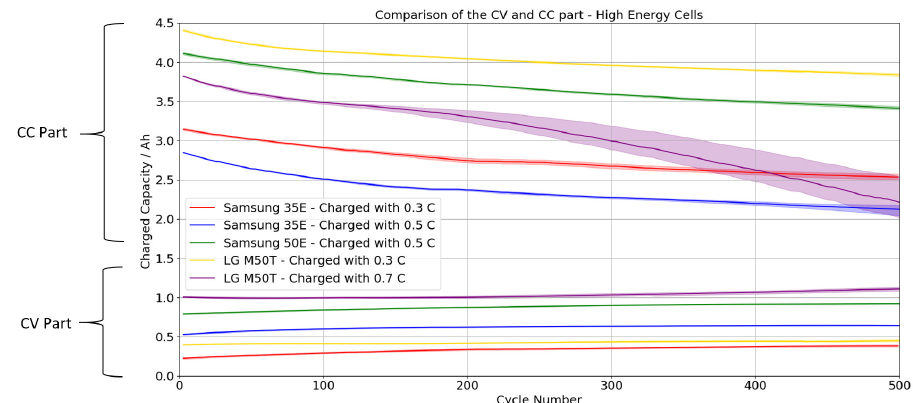
Figure 10. Development of the capacity charged during the cycle test. Separation of the CC and CV part for high energy cells.